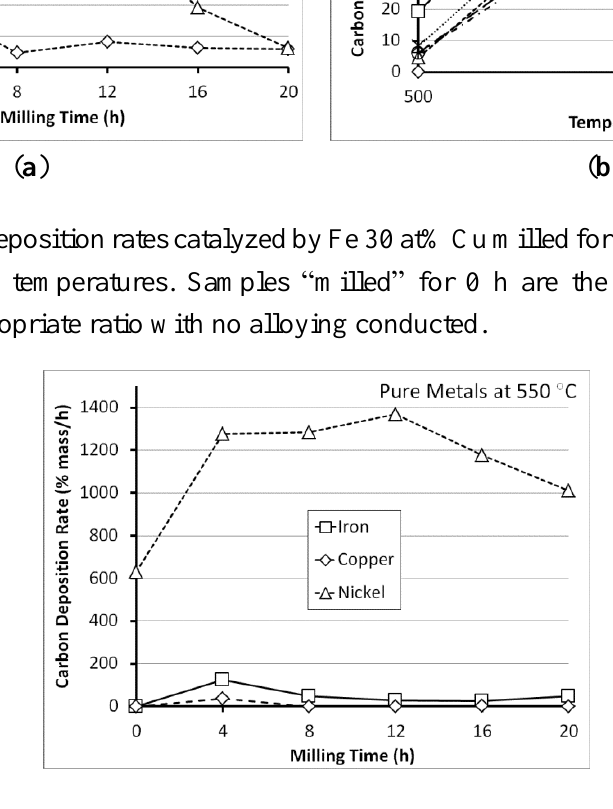
Figure 8. Carbon deposition rates catalyzed by pure metals used to create alloys. Samples “milled” for 0 h were used as-is, directly from the supplier. The character of the carbon deposited is also of interest, and Ni–Cu and Fe–Cu alloys milled for 4 h and reactions conducted at 550 °C were chosen for further analysis as these were the optimum conditions for both alloys. As shown in Figure 9, the Ni–Cu alloy forms smaller fibers which generally have a smoother, straighter morphology. Due to the large volume of growth observed in the Ni–Cu alloys, it is expected the original catalyst particles are significantly disintegrated and the catalyst is redistributed throughout the fiber mass. Fibers deposited on the Fe–Cu alloy followed closely to the shape of the original particles and are expected to be closer to the catalyst